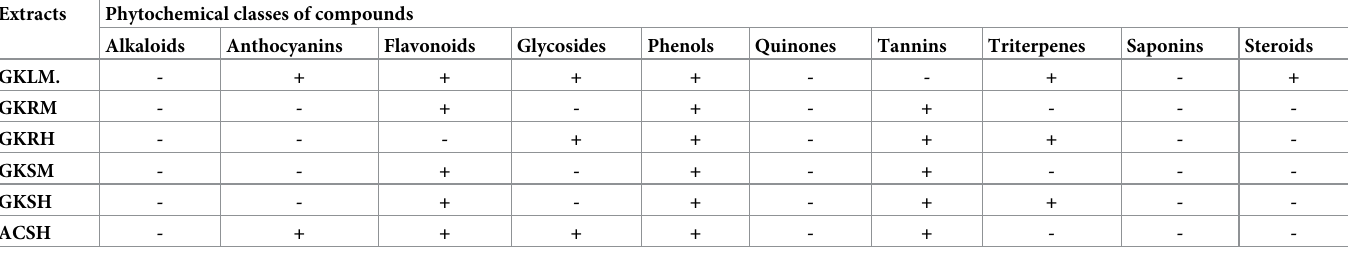
Table 2. Phytochemical composition of G . kola and A . cordifolia extracts.